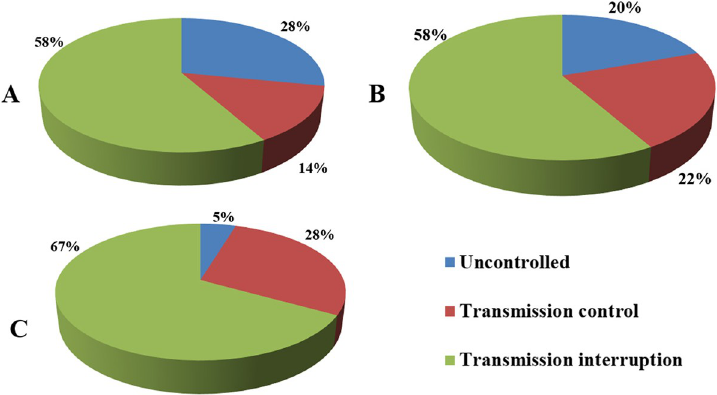
Fig 2. The changing proportions of infection control categories among schistosomiasis-endemic counties in different periods of schistosomiasis control in China from 1999 to 2019: (A) 1999, (B) 2009, and (C)